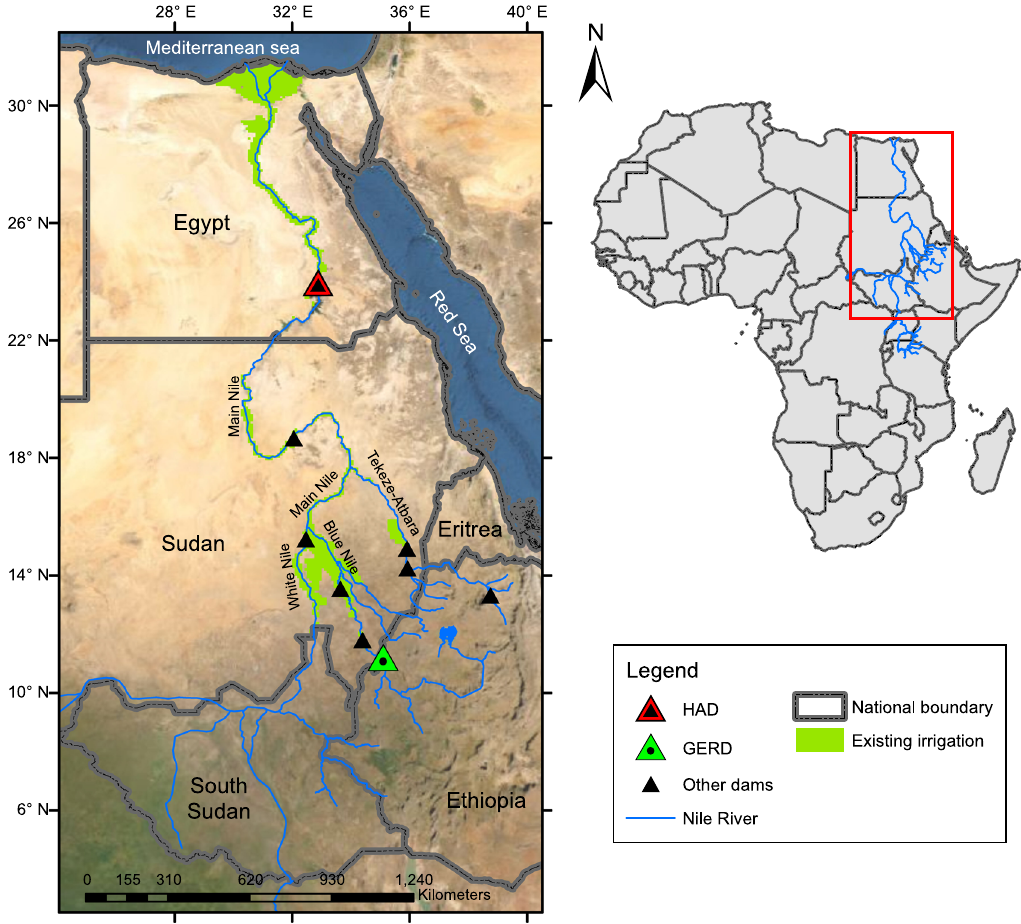
Fig. 1 Major dams and existing large-scale irrigation in the Eastern Nile River Basin. The true-color image shown in the fi gure ’ s background is based on the satellite imagery of the world managed by the Environmental Systems Research Institute (ESRI). The existing irrigation layer is based on the Global Map of Irrigation Areas (GMIA) developed by the Food and Agriculture Organization (FAO) of the United Nations. The national boundary layer is based on the Database of Global Administrative Areas